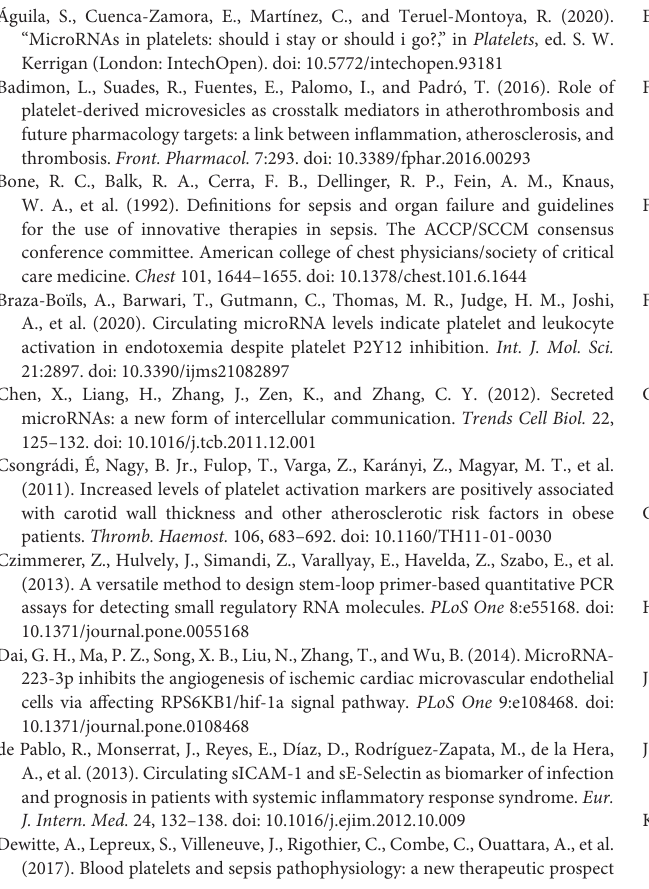
Supplementary Table 2 | Sequences of primers that were used in RT-qPCR analysis. In case of stem-loop reverse transcription primers, the miRNA